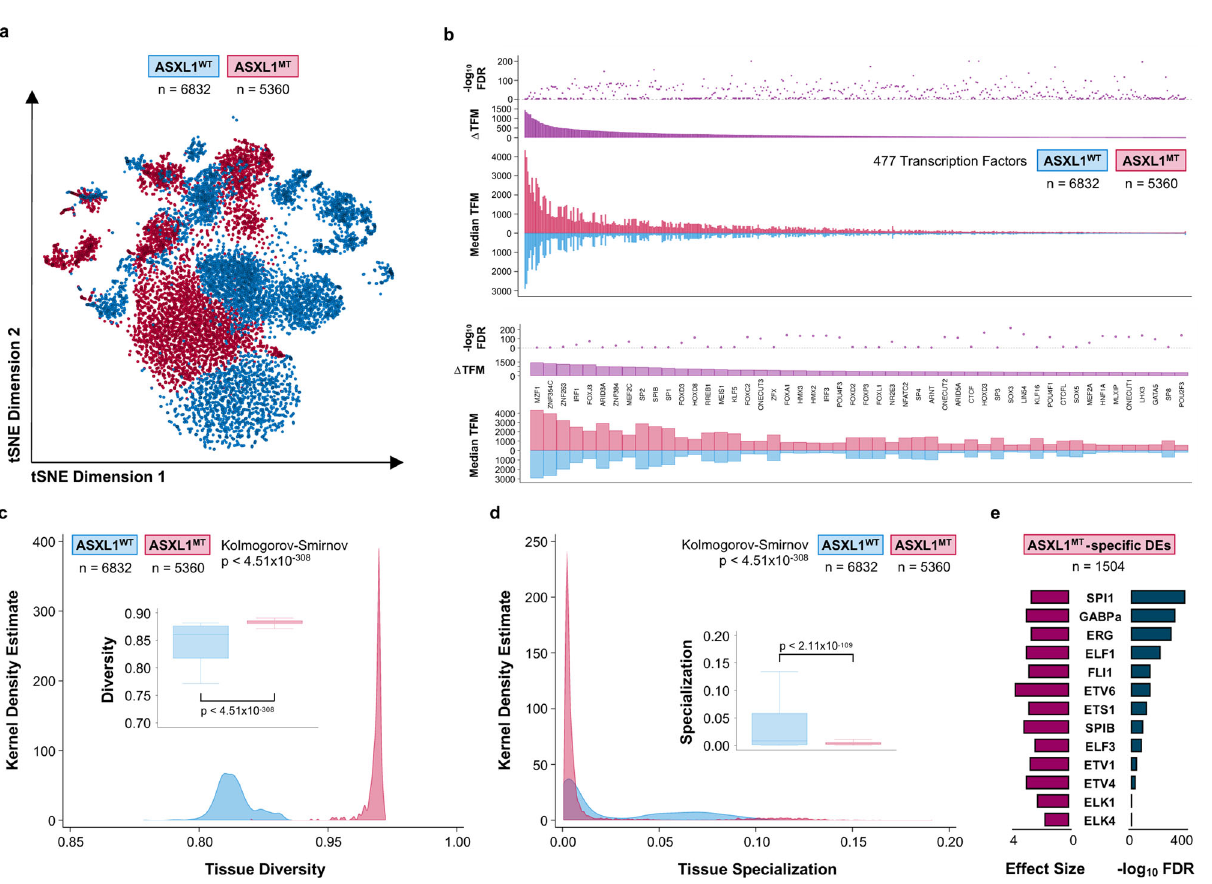
Fig. 6 ASXL1 MT CMML is associated with increased intratumoral heterogeneity secondary to an extended repertoire of accessible distal enhancers. a Scatter plot showing 12192 single cells from CMML patients (strati fi ed by ASXL1 genotype) in two-dimensional tSNE space, clustered based on